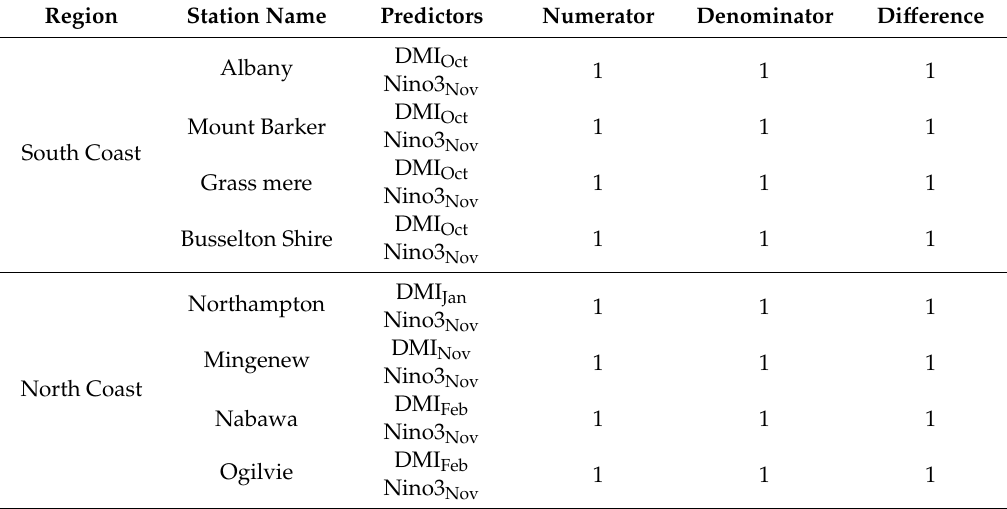
Table 4. Transfer function input.